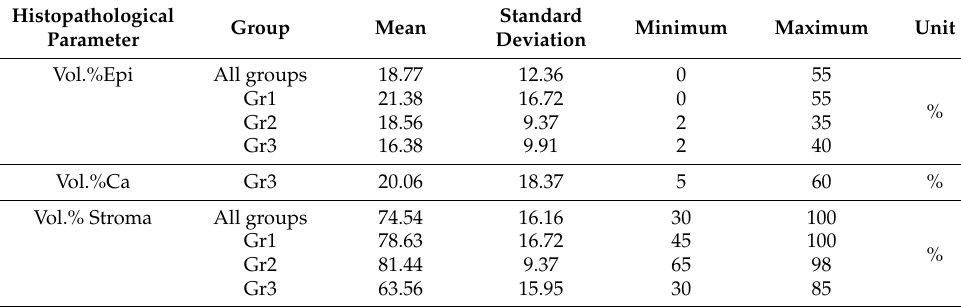
Table 3. Histopathological evaluation of MRS scanned biopsy cores. Histopathological